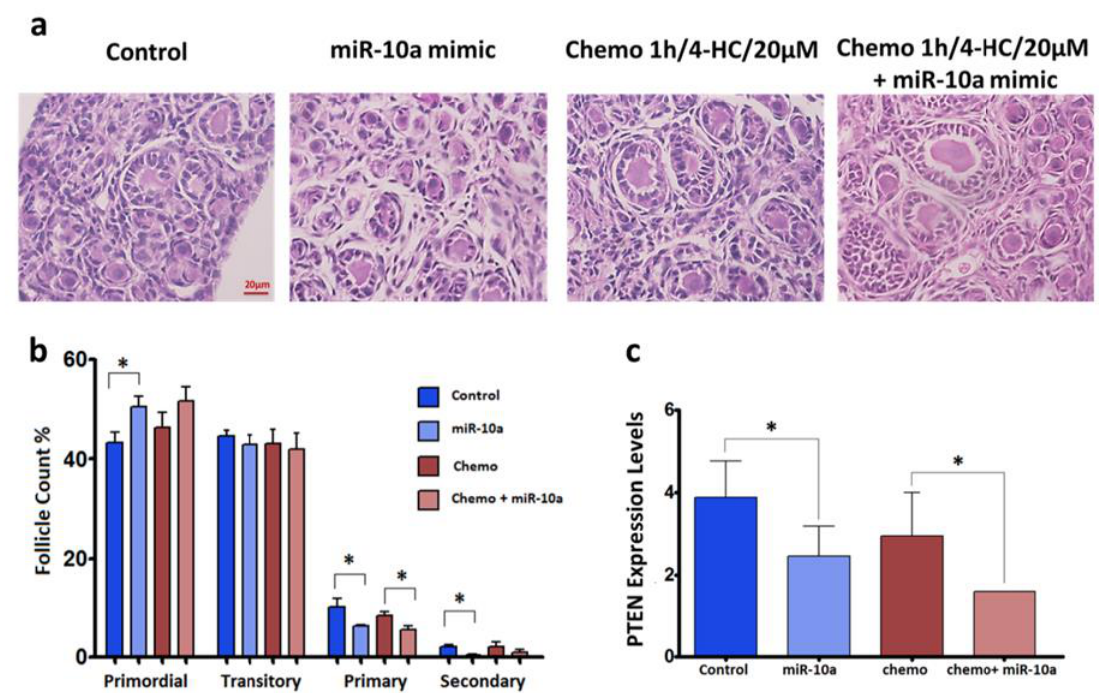
Figure 4. Functional analysis of miR-10a replacement approaches by follicle development evaluation. ( a ) Hematoxylin and eosin (H&E) staining on 5-µm sections of PND3 ovaries in different conditions. ( b ) The graph shows the percentage of follicles according to developmental stages (primordial, transitory, primary, secondary) in four different groups. The follicle counting was performed in at least three different experimental samples for each group ( n ≥3). The error bars represent the standard error, p < 0.05. ( c ) The graph represents the expression levels of the miR-10a targeted gene, PTEN. PTEN is significantly downregulated in both the miR-10a mimic ( n = 8) and chemo + mir-10a ( n = 7) groups. The error bars represent the standard error, paired t-test, * p < 0.05.